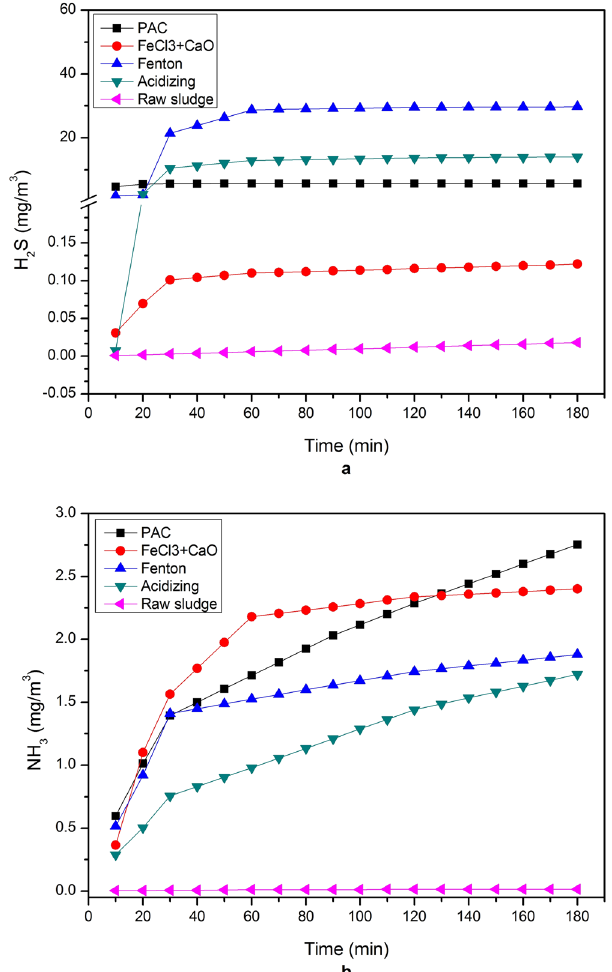
Figure 4. Effect of four sludge dewatering methods on the concentration of H2S ( a ) and NH3 ( b )